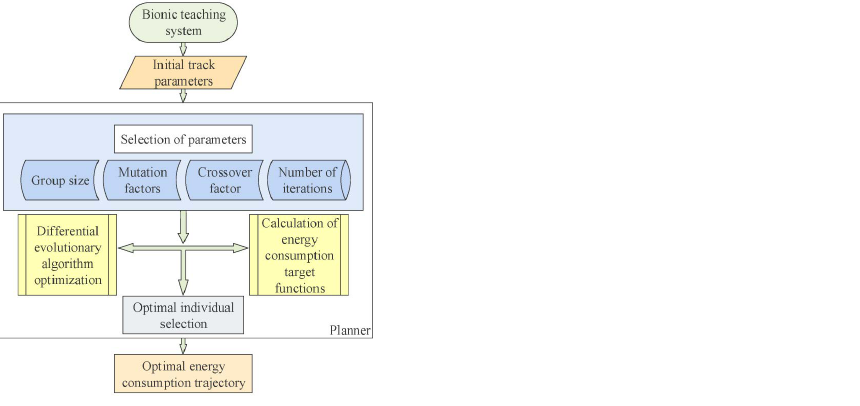
Figure 7. Process of energy saving planner reducing energy consumption of trajectory